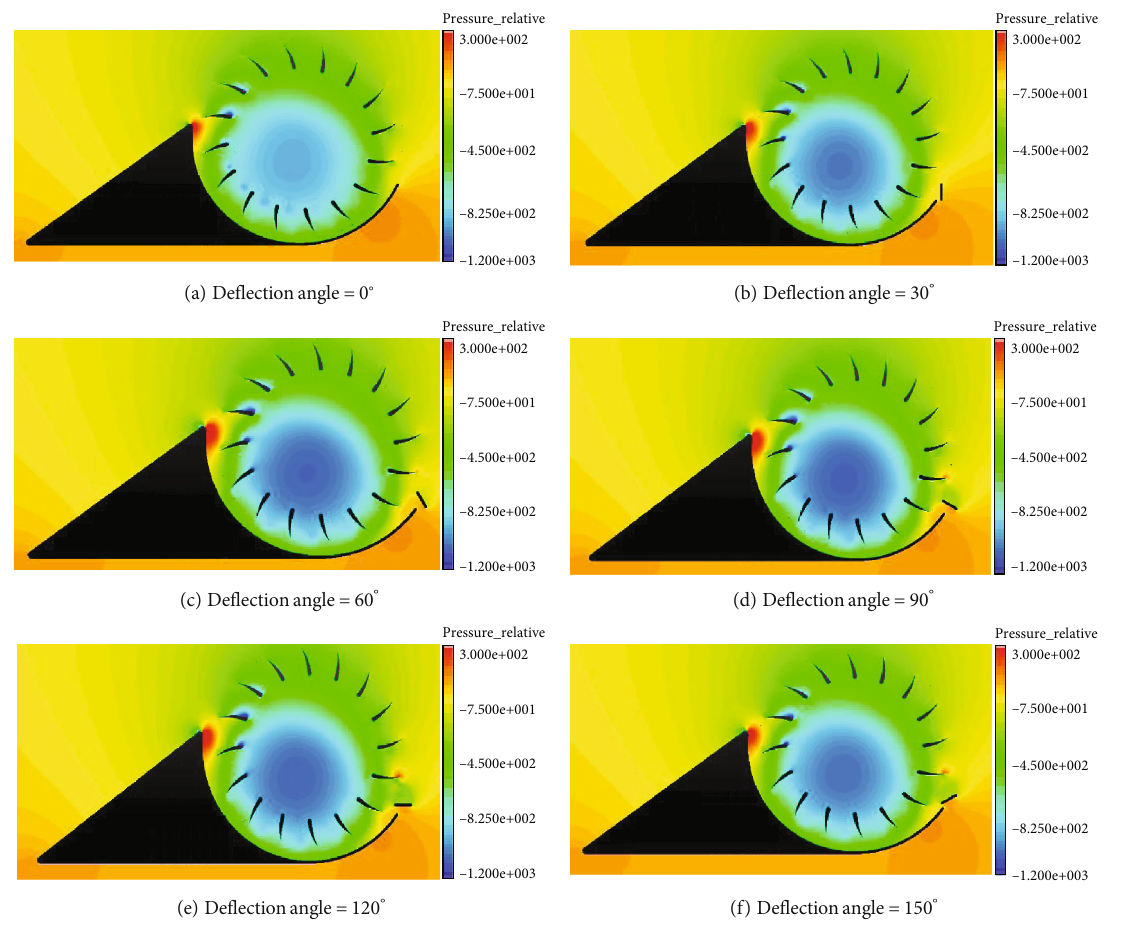
Figure 9: Pressure nephogram of a single leading edge winglet ( v = 12 m/s, α = 0 ° ).